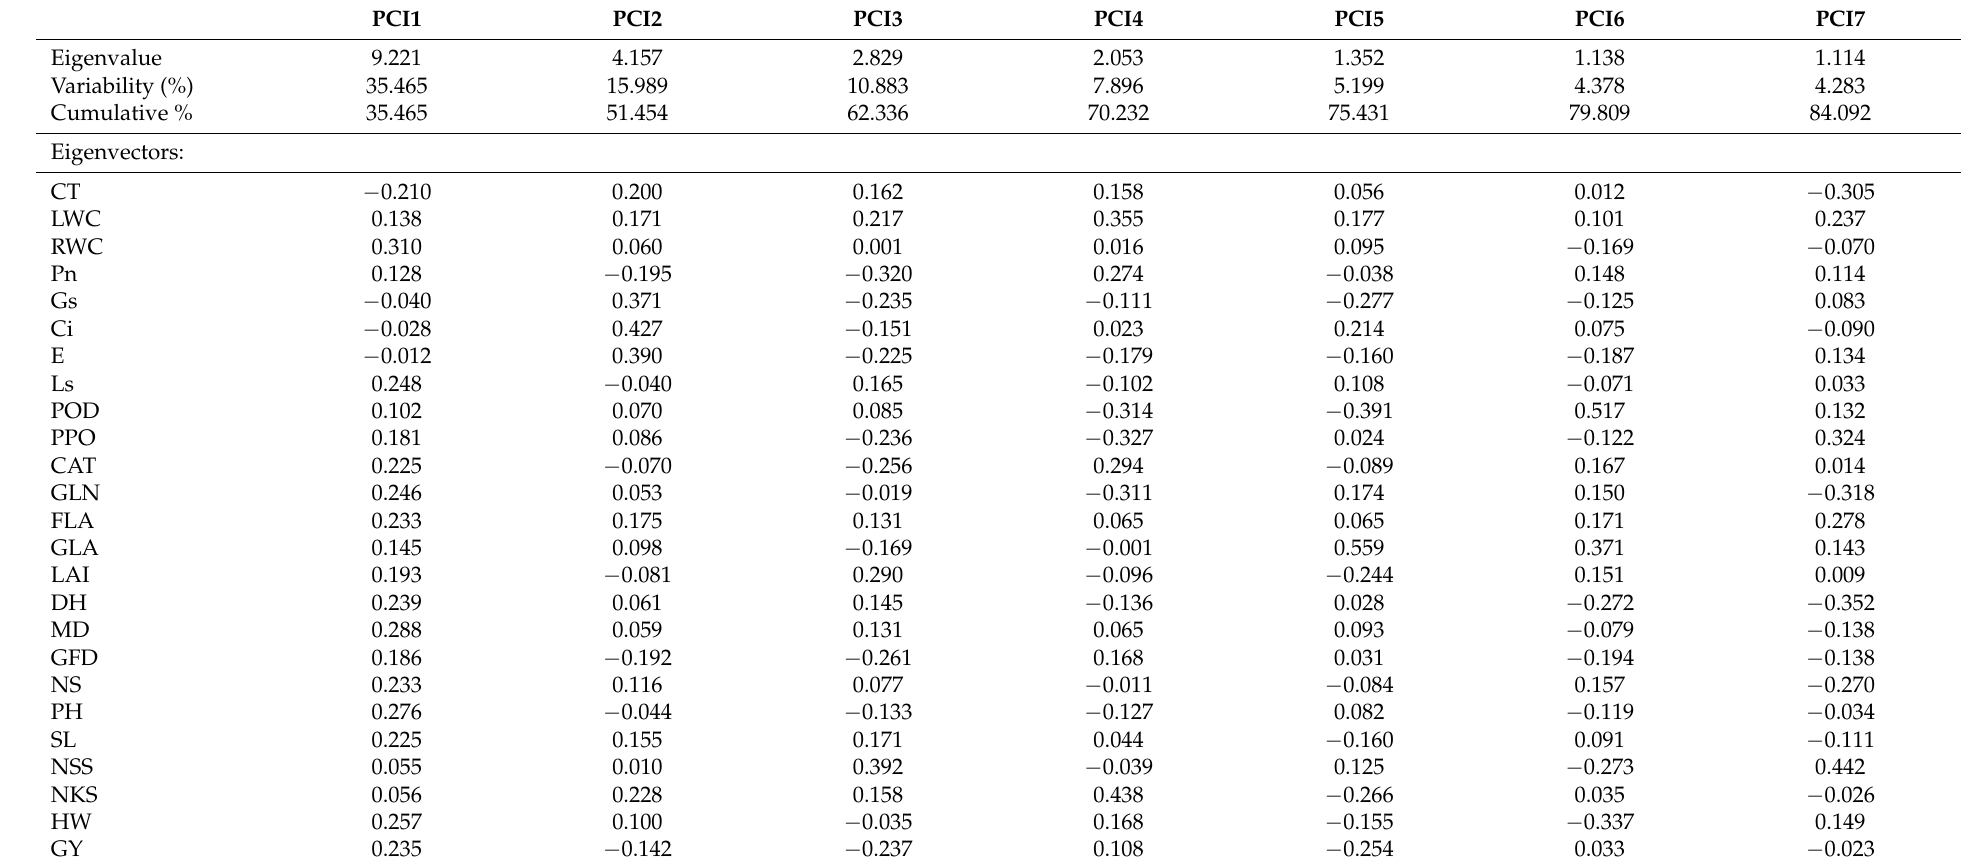
Table 3. Eigenvectors and percentage of accumulated contribution of principal